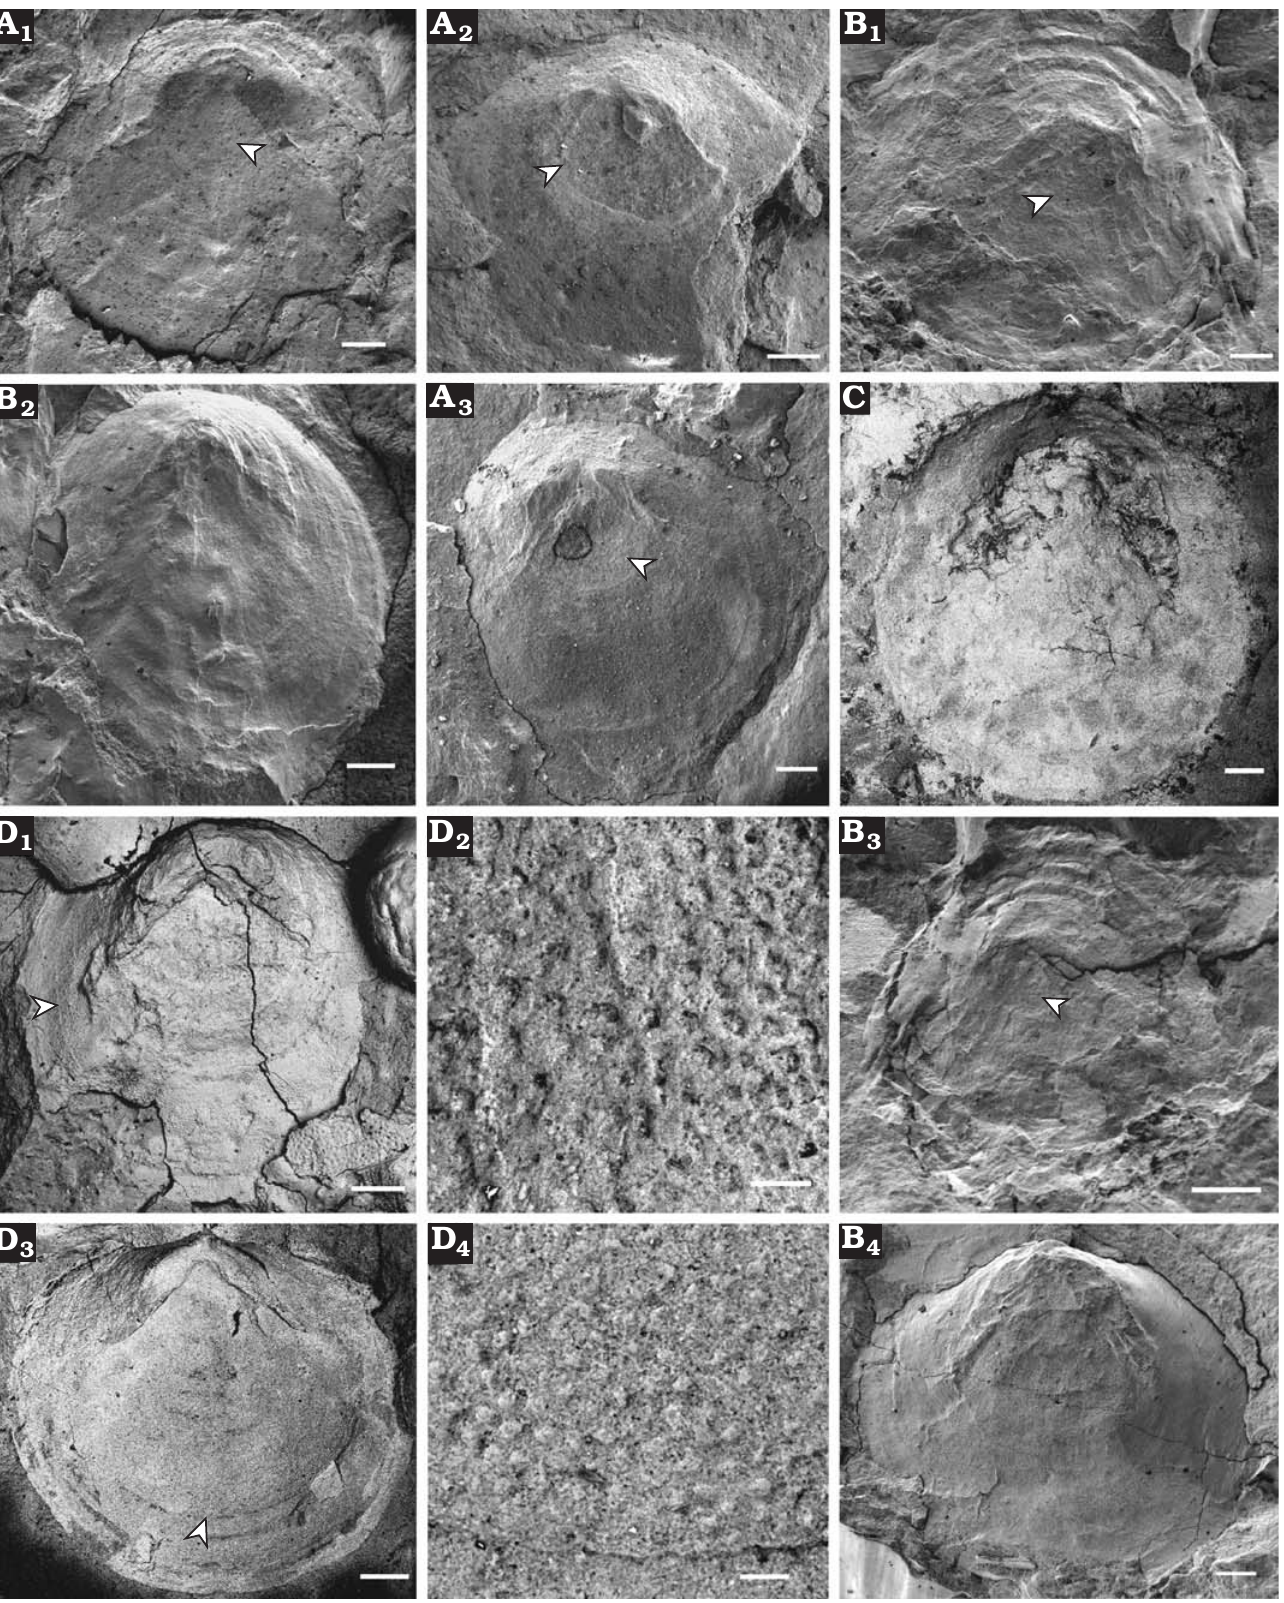
Fig. 6. Opercula of cupithecid hyolith Cupitheca convexa sp. nov. preserved as internal or external moulds, which are prepared from natural casts, col- lected from the Manto Formation (Cambrian Stage 4/5) in the Zuojiawu section of Tangshan, China. A , B . Internal moulds of opercula, NIGPAS 166337 ( A ) and NIGPAS 166342 ( B ); showing exteriors covered with concentric ribs, protoopercula (indicated by white arrows) and imprints of bilobate cardinal